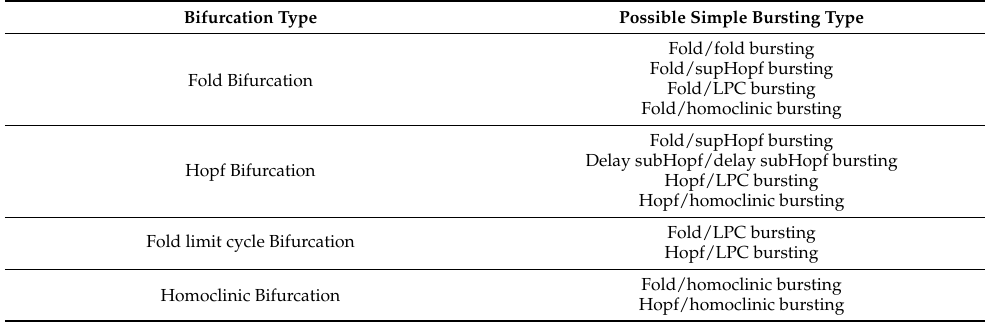
Table 1. Several simple bifurcation types and their possible simple bursting